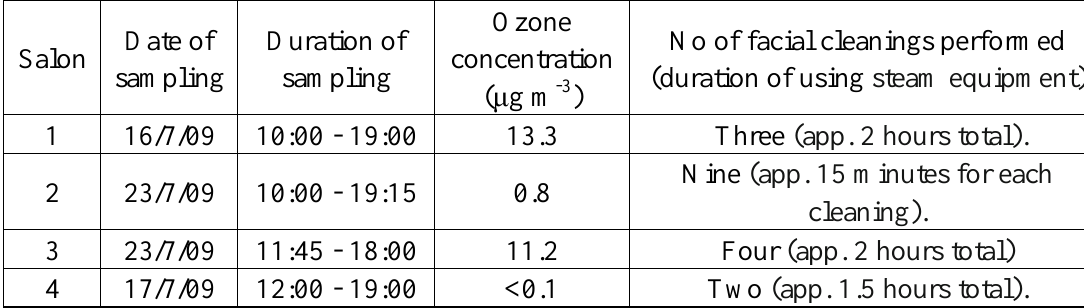
Table 4. Ozone concentrations measured in four